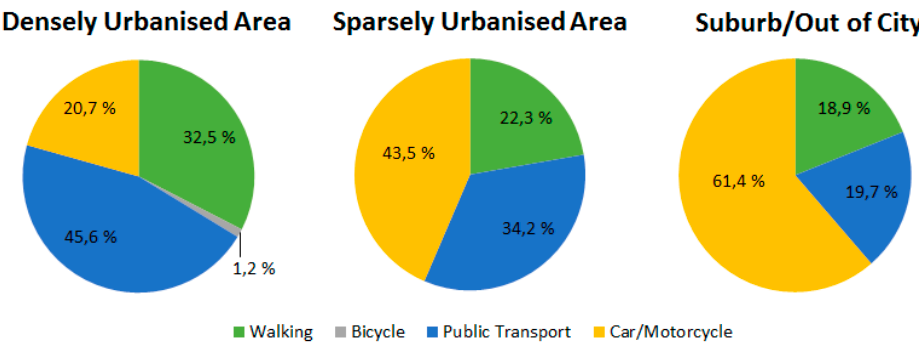
Figure 5. Proportion of routes according to means of transport in different types of urbanised areas in Olomouc and Ostrava.